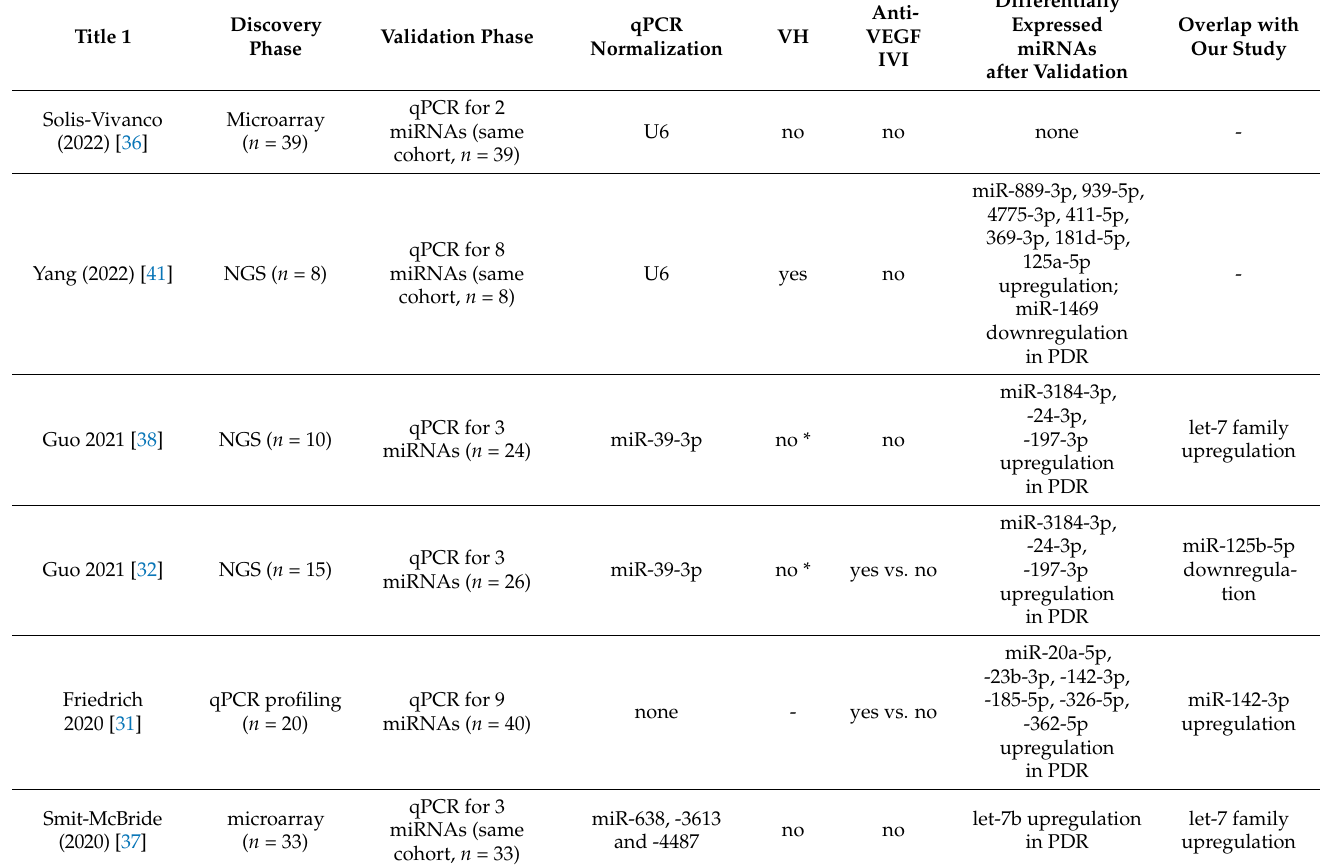
Table 3. Studies assessing miRNA expression in vitreous humor in